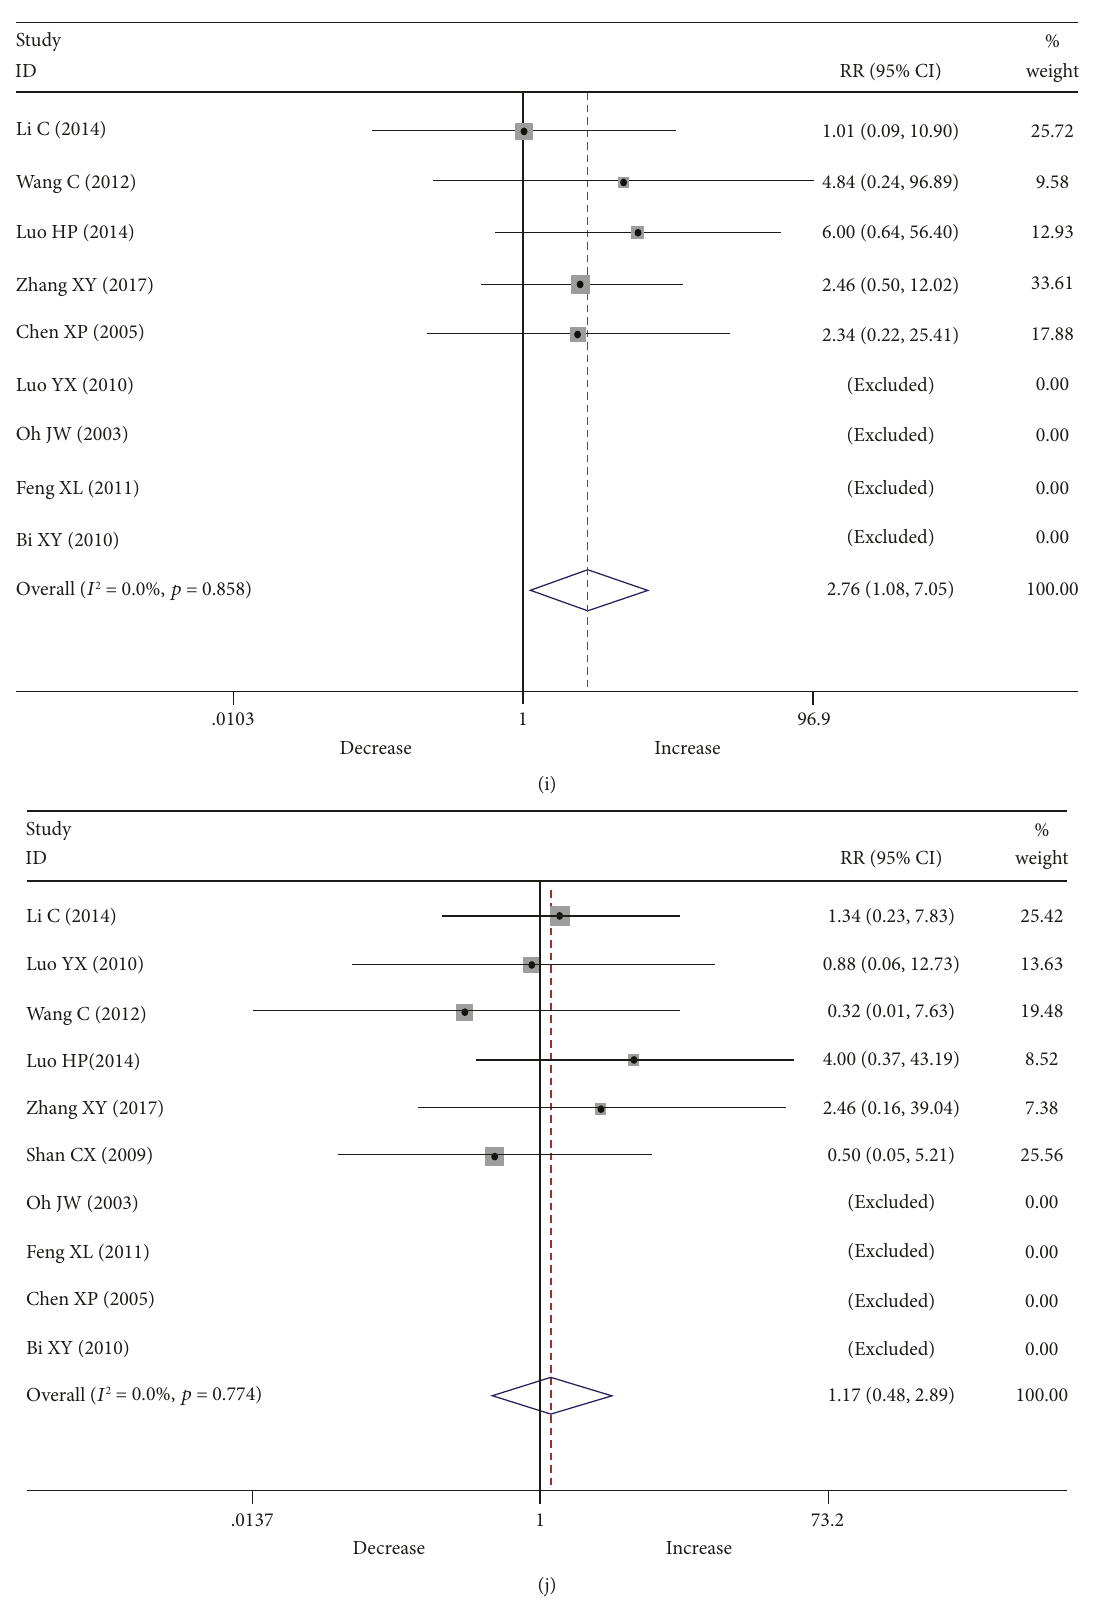
Figure 3: Meta-analysis of comparison between the HS and HA groups for (a) operation time, (b) intraoperative blood loss, (c) intraoperative blood transfusion, (d) postoperative complications, (e) perioperative mortality, (f) infection, (g) ascites, (h) upper gastrointestinal bleeding, (i) abdominal bleeding, and (j) acute liver failure. Abbreviations: HS: simultaneous hepatectomy and splenectomy; HA: hepatectomy